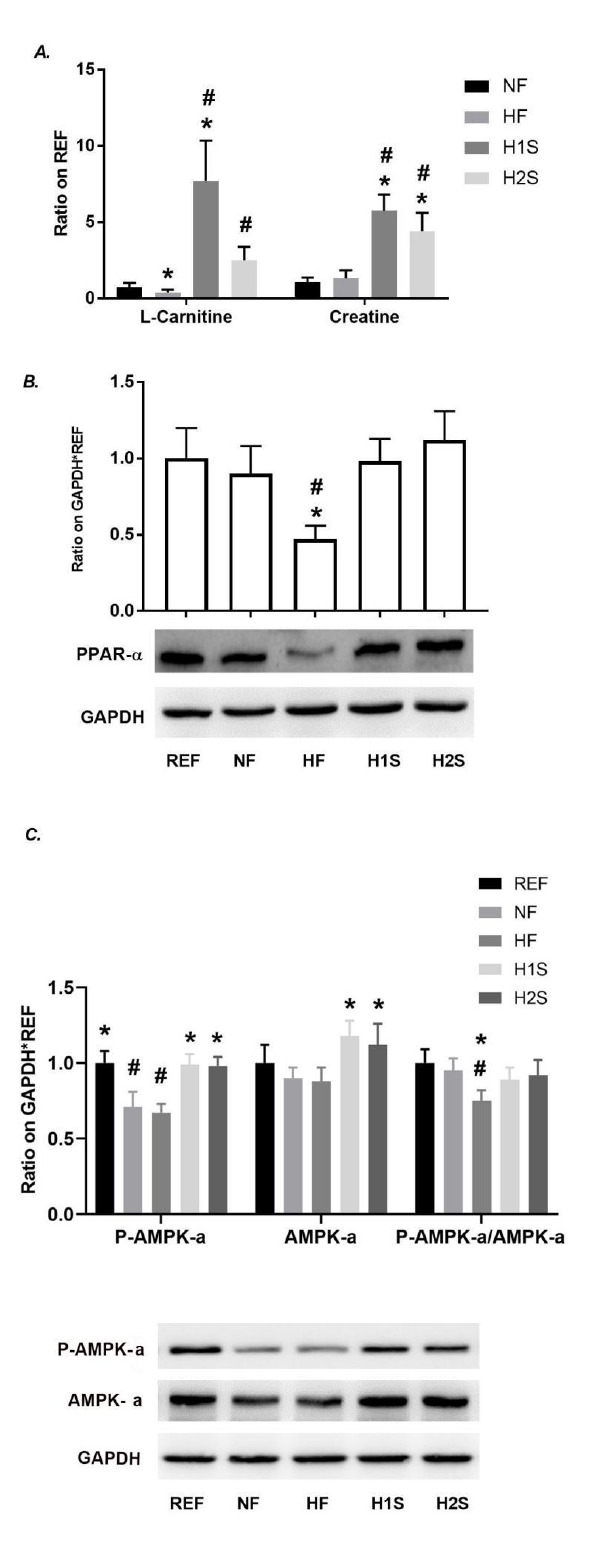
Figure 4. Maternal one-carbon supplementation promoted methyl group delivery to L-carnitine and normalized PPAR α expression and the AMPK signaling activation. ( A ) L-carnitine and creatine content was detected via high-resolution UPLC-MS/MS. ( B ) PPAR- α expression was detected by western blots in male offspring. ( C ) AMPK- α and phospho-AMPK- α (Thr172) expression were detected by western blots in male offspring. Relative amounts were expressed as the ratio of Phospho- AMPK- α (Thr172)/AMPK- α . Data are presented as the mean ± SE, n = 5. * indicates p < 0.05 vs. the NF group. # indicates p < 0.05 vs. the REF